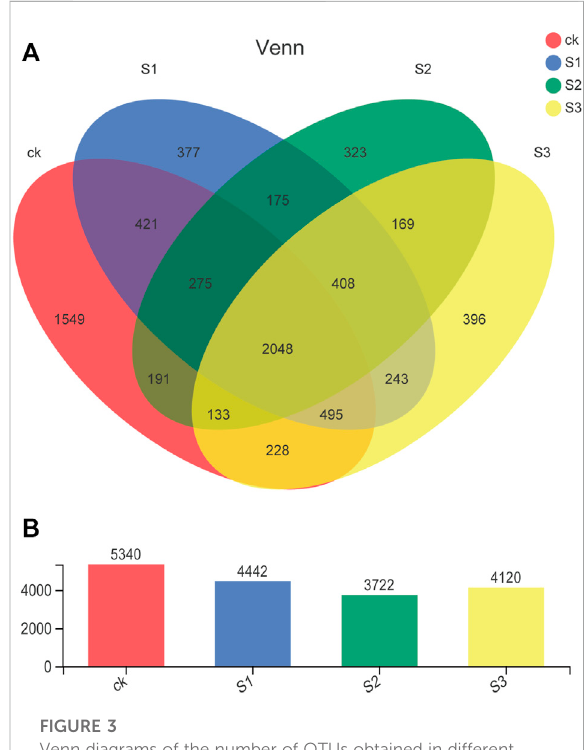
FIGURE 3 Venn diagrams of the number of OTUs obtained in different treatments. Values represent the number of OTUs. (A) Venn diagram and (B) average total OTUs of different